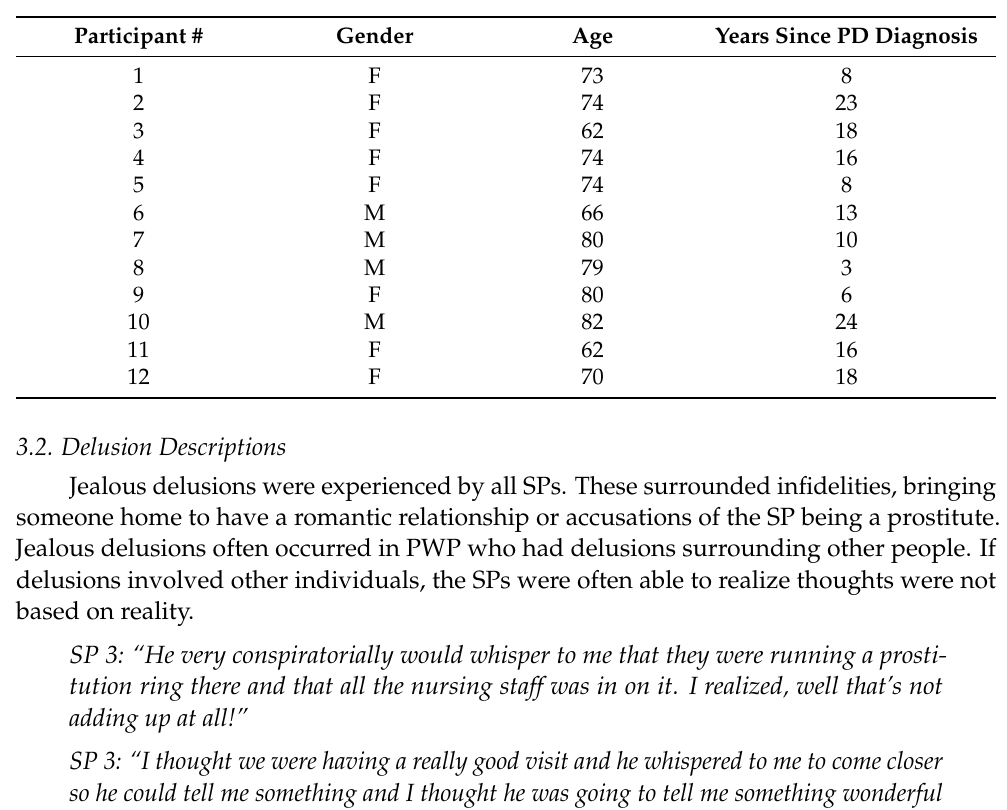
Table 1. Participants’ demographic